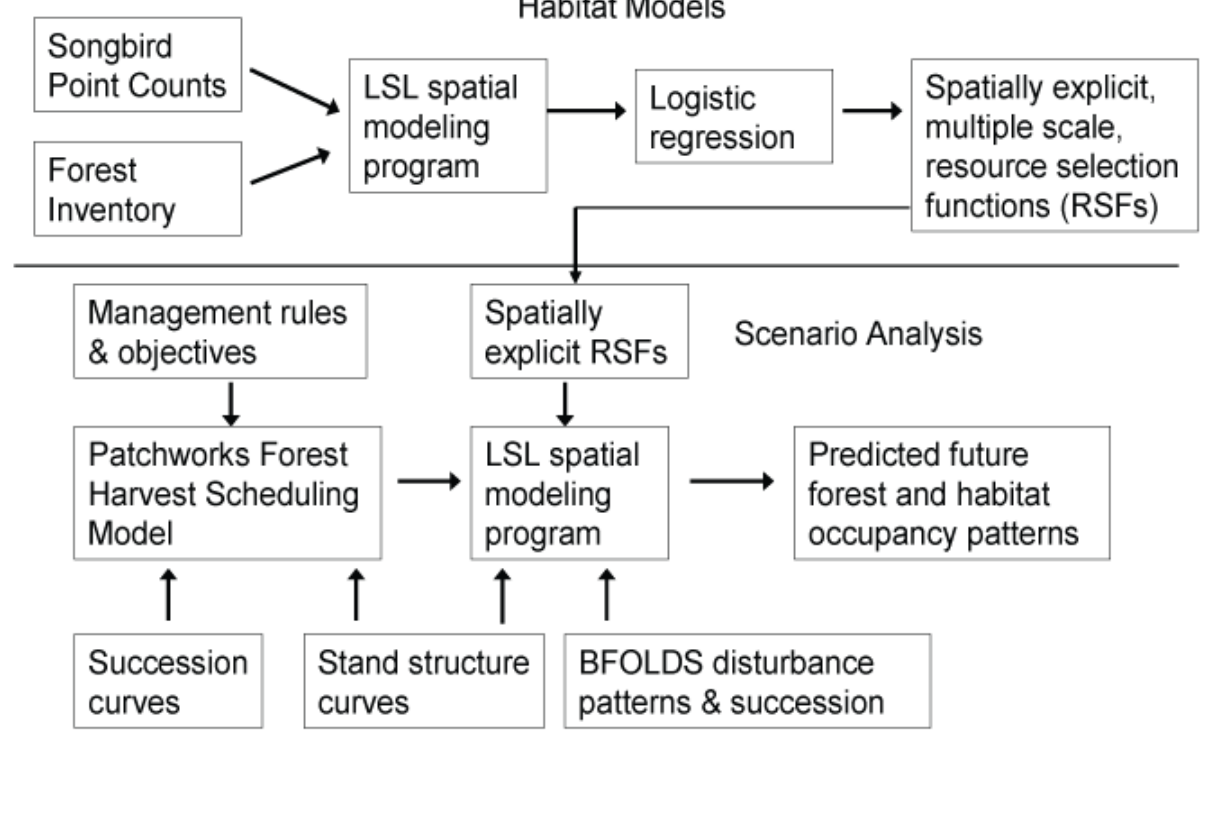
Fig. 2. Schematic diagram (meta-model) of links between model components, flow of data, and model outputs. Upper figure describes habitat modeling components, and lower figure describes scenario analysis